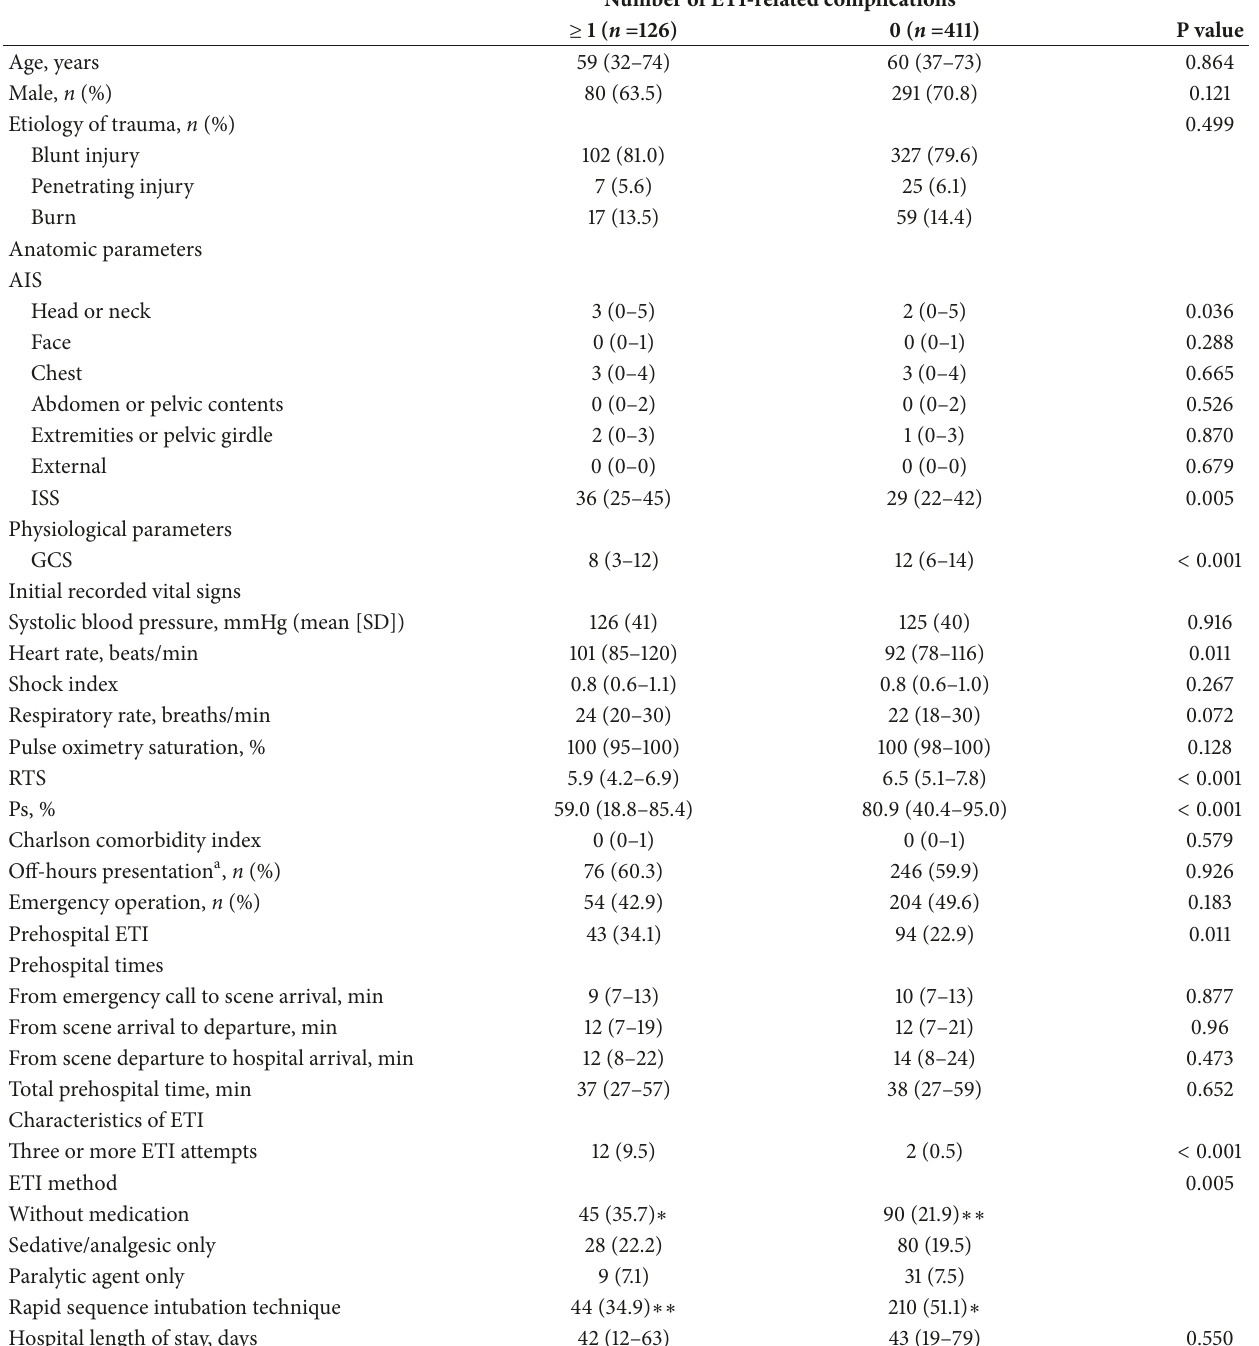
Table 2: Demographic characteristics of trauma patients, according to occurrence of ETI-related